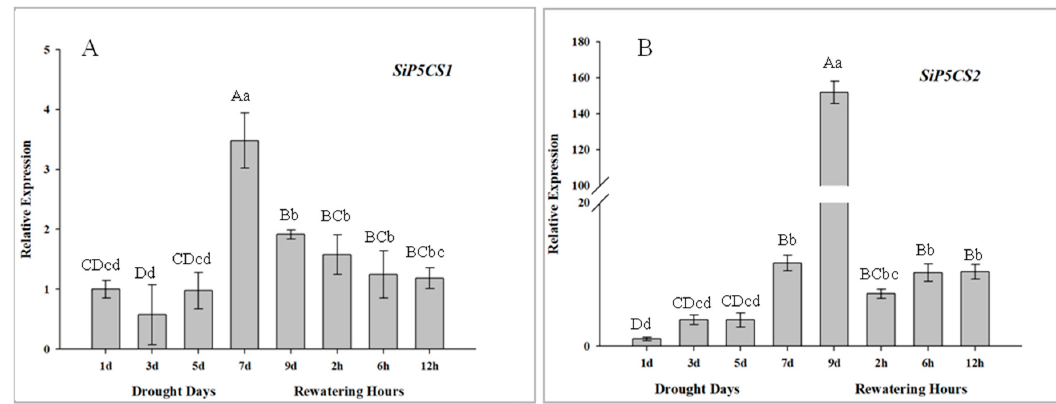
Figure 10. Analysis of differential expression of SiP5CS genes under drought and rehydration conditions in leaves. ( A ) SiP5CS1 . ( B ) SiP5CS2 . Each column represents the mean ± SD ( n = 3). Significance levels were determined by one-way ANOVA; Different letters above bars indicate significant differences, lowercase letter p < 0.05, uppercase letter p < 0.01.